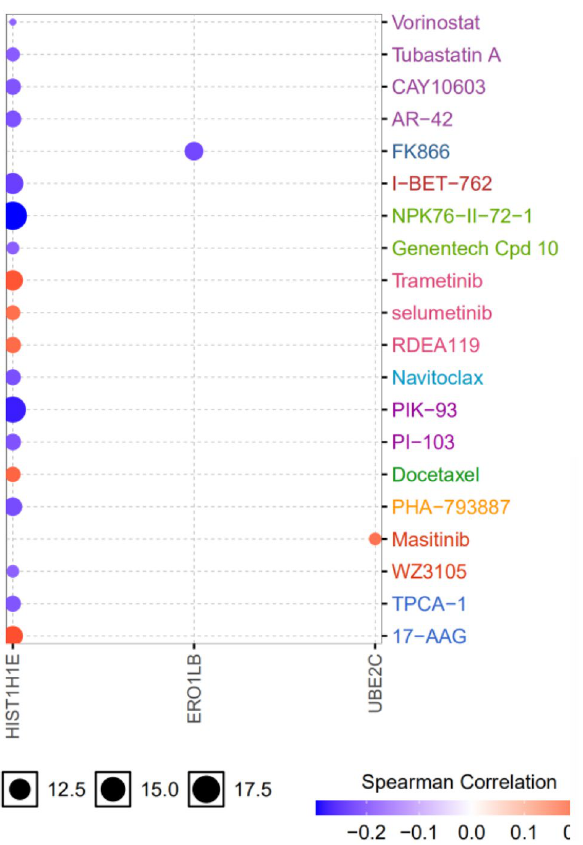
Figure 10. Potential drugs screened from GSCA database. Red nodes represent positive correlation and blue nodes represent negative correlation. The larger the node, the stronger the correlation. Positive correlation means that the high expression of the gene is resistant to drugs, and vice